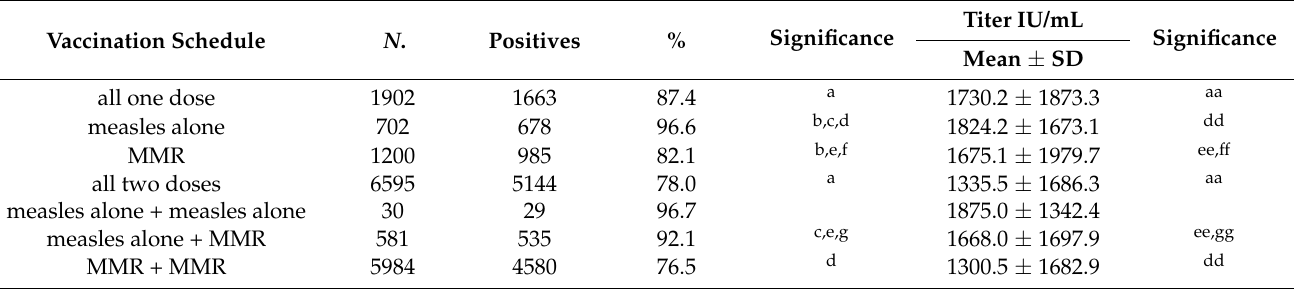
Table 2. Percentage of positive students and antibody titer according to vaccination